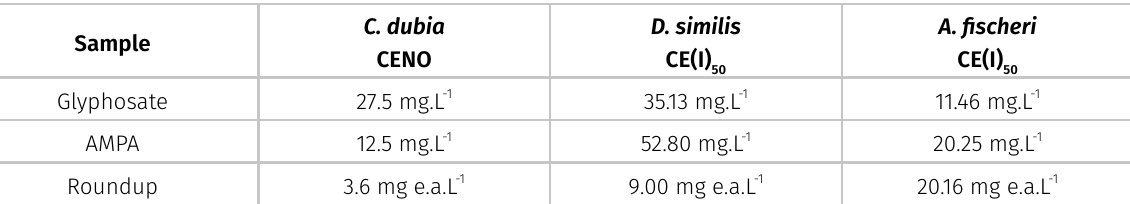
Table III. Ecotoxicological